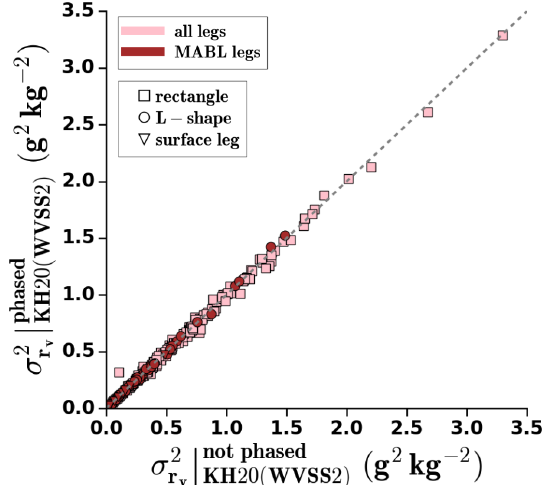
Figure 5. Variance of the water vapor mixing ratio computed with the KH20 sensor, after calibration with the WVSS2 sensor phased in time, versus the variance obtained when the WVSS2 sensor is not phased. The comparison is done for all flights from RF11 to RF19, considering either the entire set of legs or just the legs flown within the MABL. The markers refer to the different types of leg, as sketched in Fig. 1.